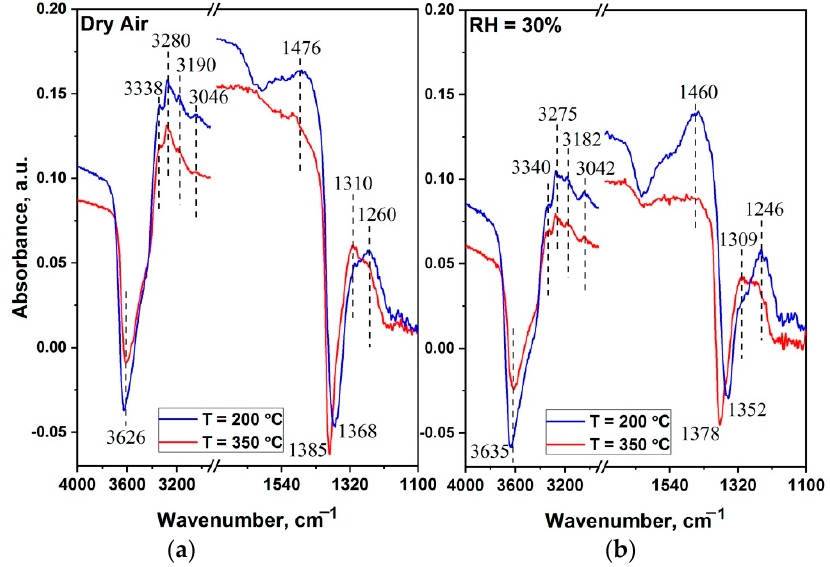
Figure 11. In situ DRIFT spectra of 2D SnO 2 ( a ) in dry (RH 25 = 0%) and ( b ) in humid (RH 25 = 30%) air containing 100 ppm NH 3 at temperatures of 200 ◦ C (blue line) and 350 ◦ C (red line). In general, the spectra obtained at 200 ◦ C and 350 ◦ C in dry and humid air are similar (Table 2), but there are also differences corresponding to the type of change in